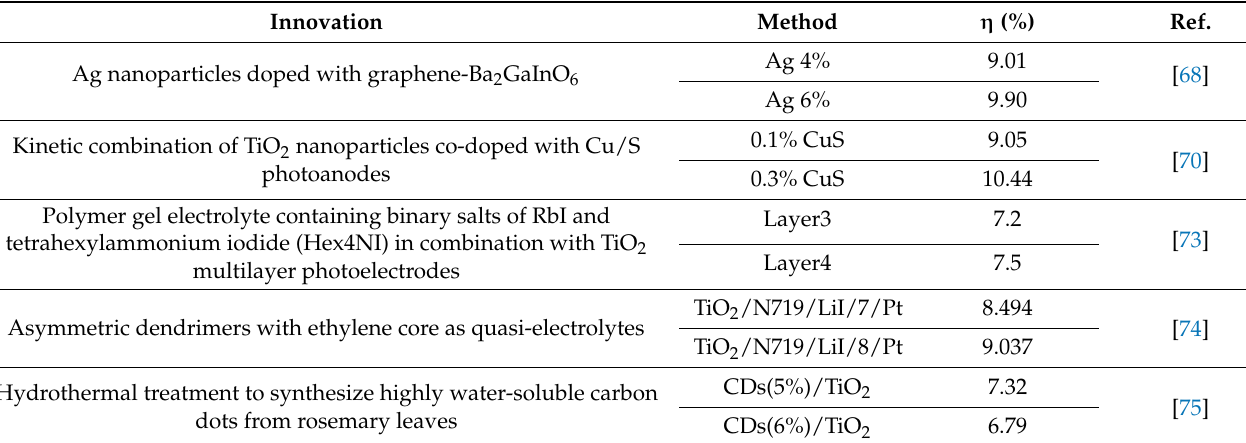
Table 8. High efficiency values reported on recent